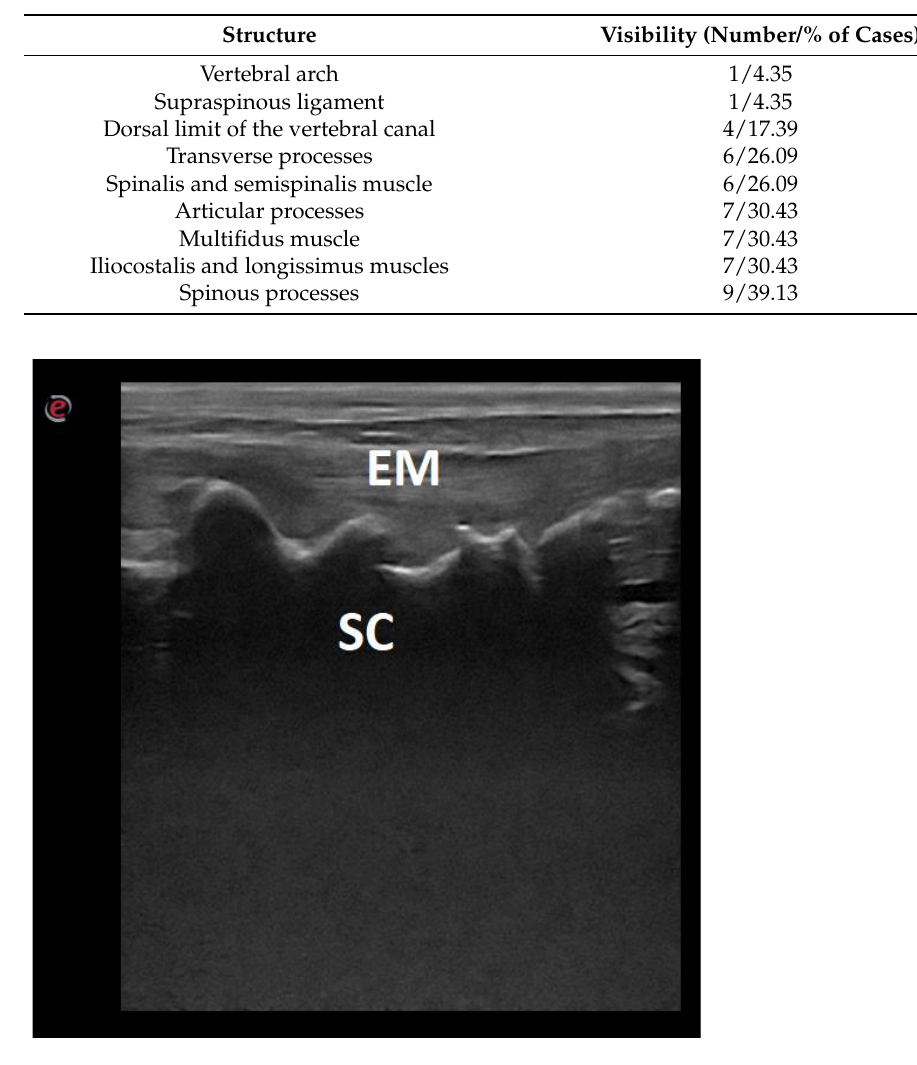
Table 3. Structures identified in the study in the transverse plane and the number and percentage of their visibility in the examined cadavers.